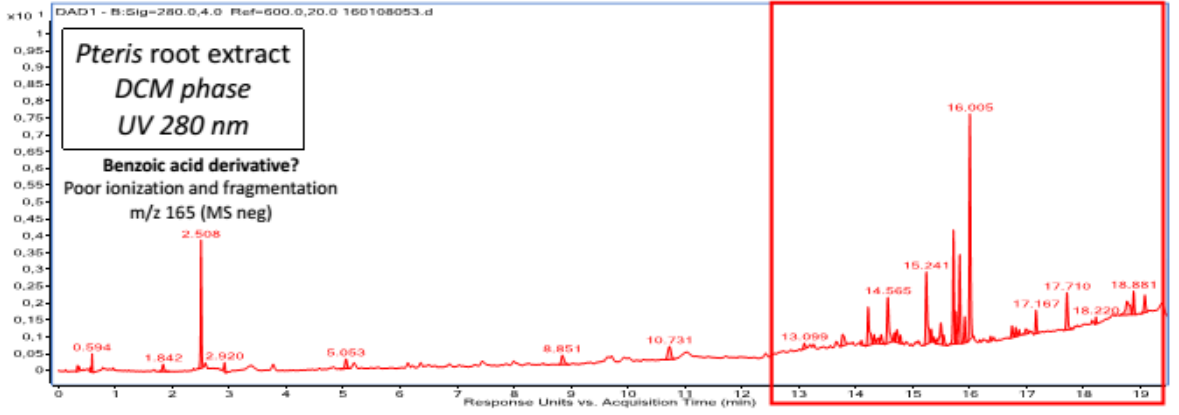
Figure A3. UHPLC chromatogram with UV detector at 280 nm of P. vittata L. roots dicholoromethane (DCM) fraction.